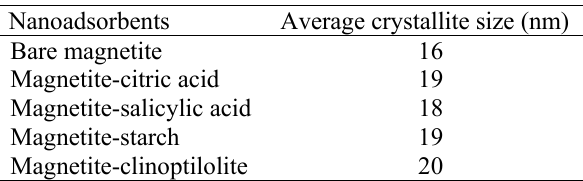
Table 1. Average crystallite size of different nanoadsorbents.